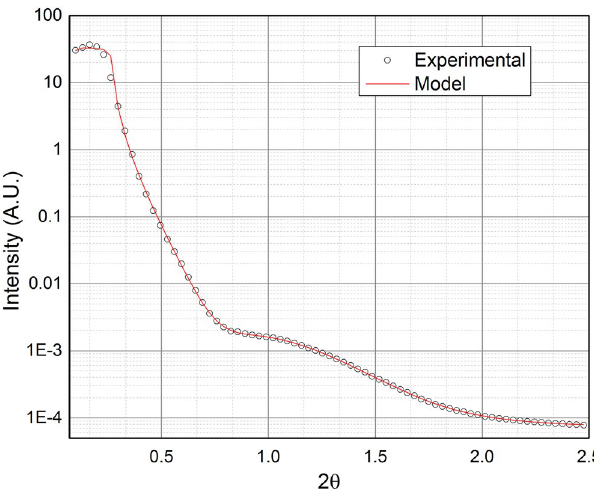
Figure 5. Comparison of the experimental XRR data (open circles) and the model used to fit it (continuous